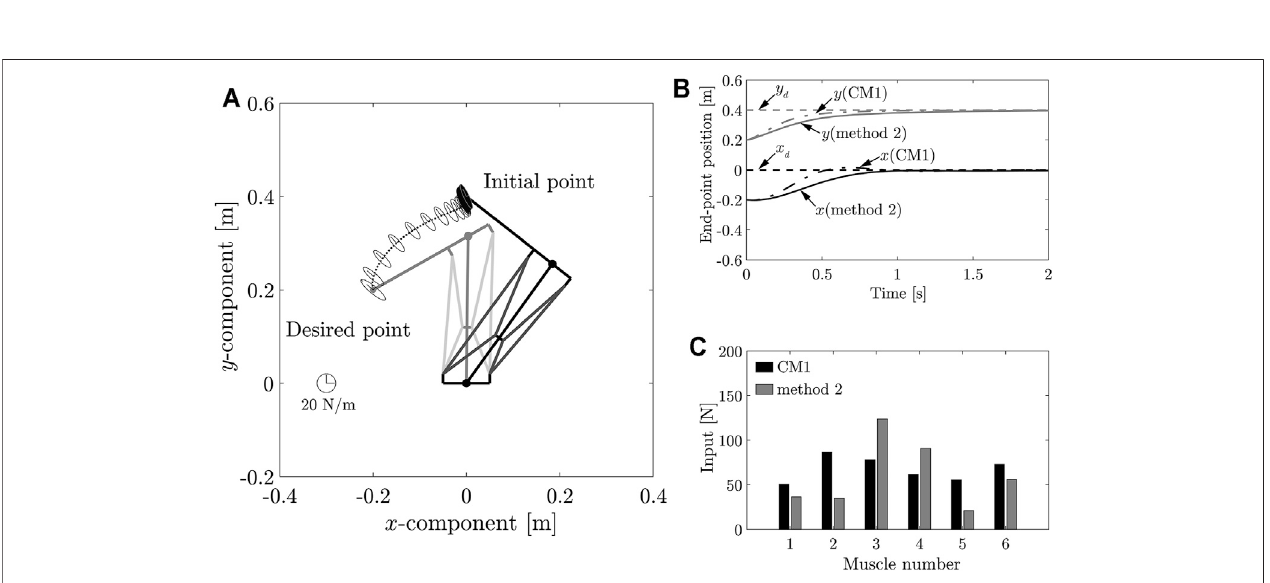
FIGURE 9 | (A) Loci of end-point positions during movement from positions B to A and end-point stiffness ellipsoids in task space. (B) Transient response of end- point position during movement from position B to position A . (C) Control input using MIF balancing at position A .